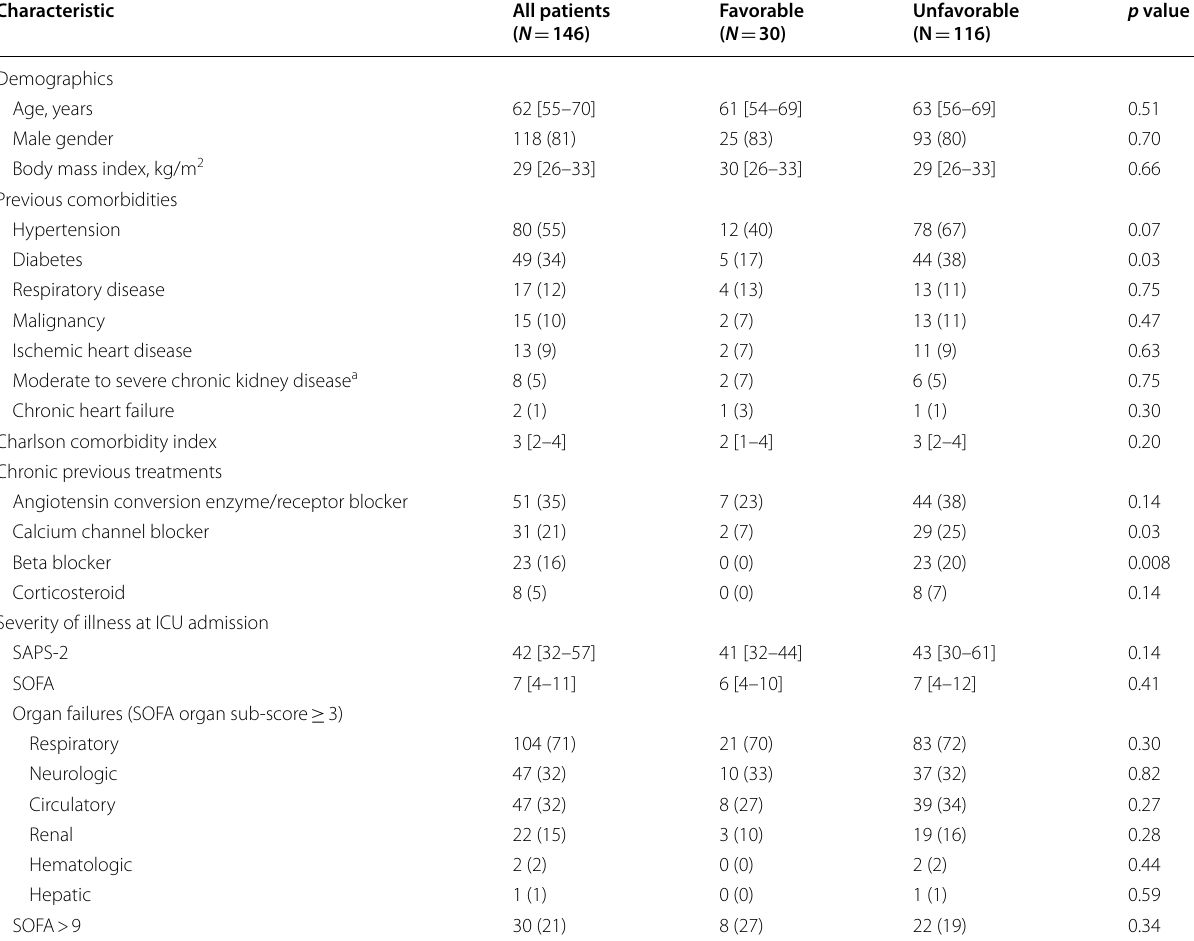
Results are expressed as N (%) or median [25–75% interquartile range] unless expressed otherwise. Favorable outcome: modified Rankin scale ranging from 0 to 3 at day 90 after CA; unfavorable outcome: modified Rankin scale ranging from 4 to 6 at day 90 after CA; ICU: intensive care unit; CA: cardiac arrest; SAPS-2: